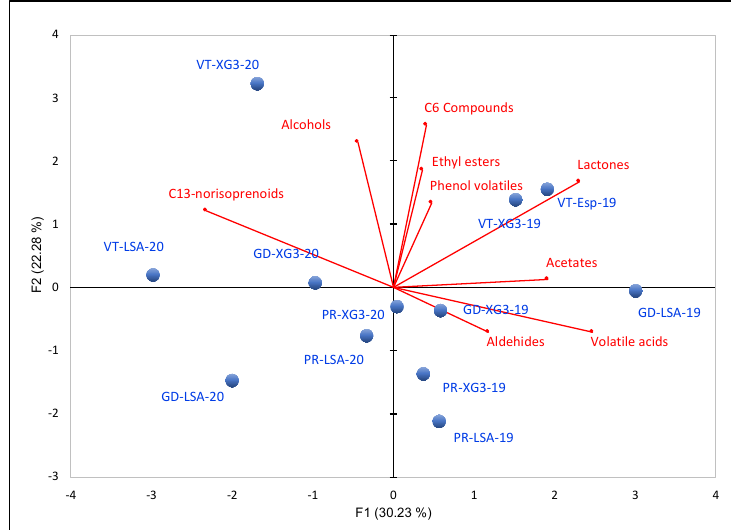
Figure 5. Principal Component Analysis from Treixadura wines from Priorato de Razamonde (PR), O´Ventosela (VT) and Gandarela (GD) wineries obtained with different yeasts in 2019 and 2020 vintages.